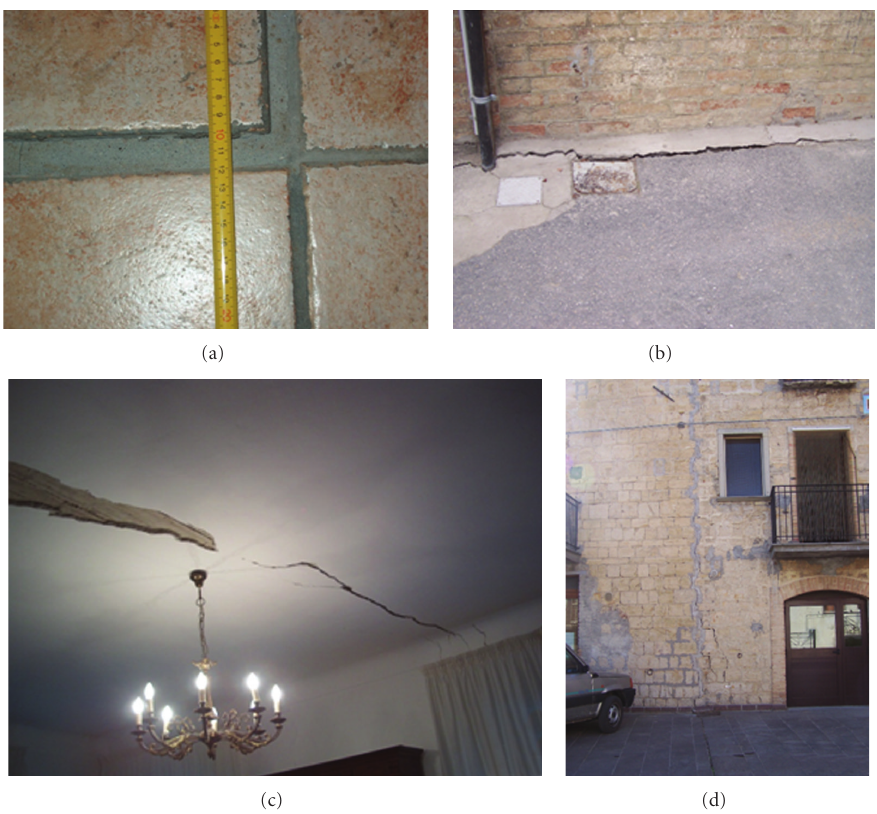
Figure 2: Photo images of cracks in the floor (a), road (b), ceiling (c), and building walls